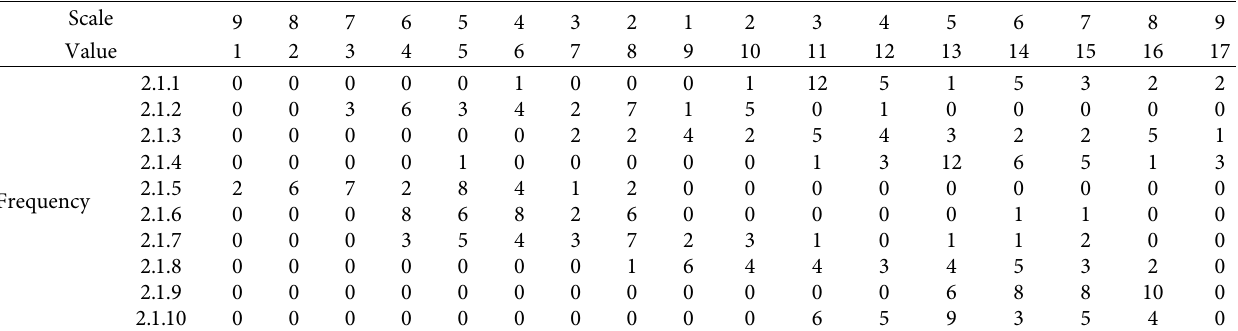
Table 5: Frequency of part two of the questionnaire.